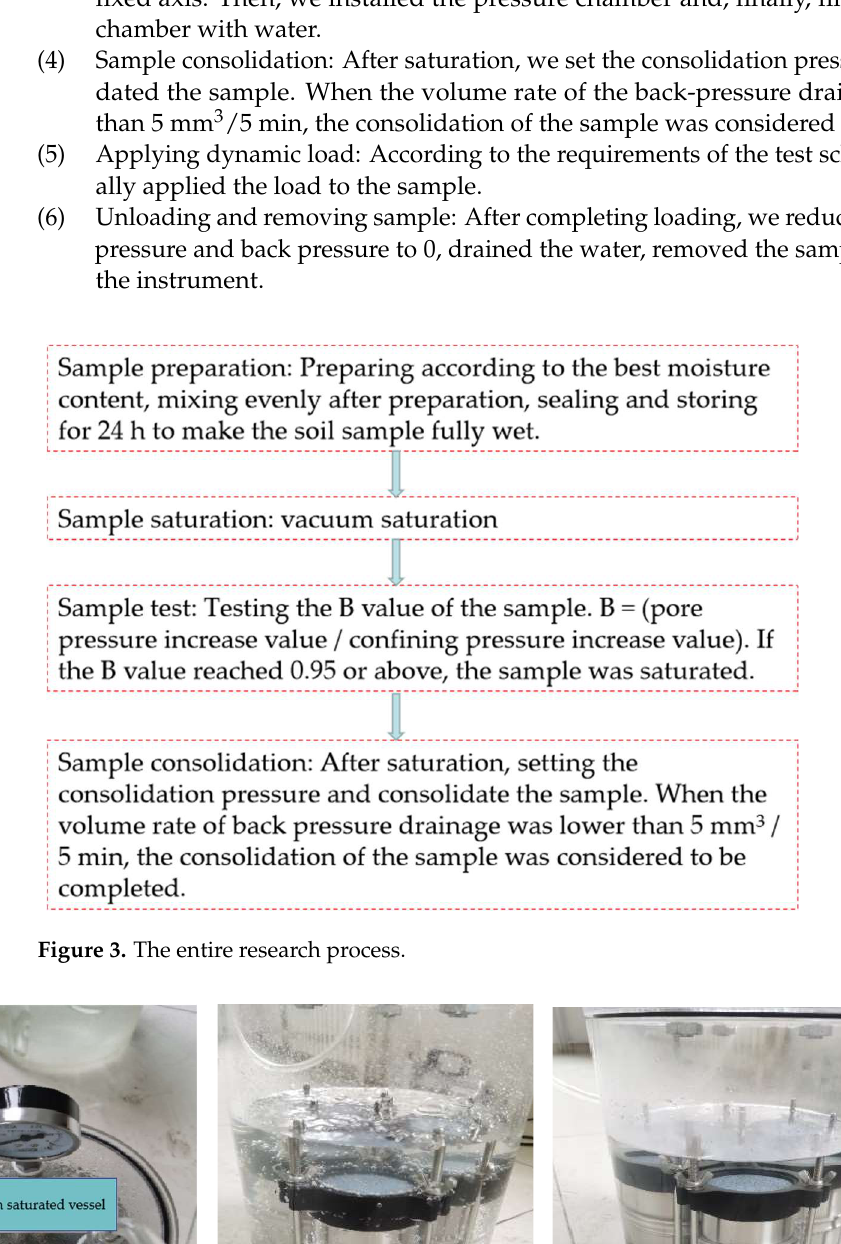
Figure 4. Vacuum